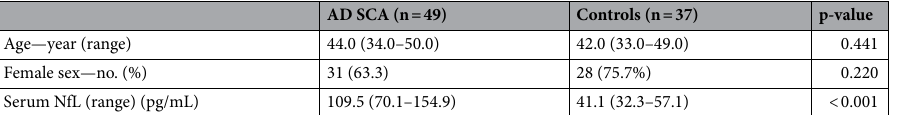
Table 2. Patient characteristics and serum neurofilament light chain of autosomal-dominant spinocerebellar ataxia patients and controls. Data are reported as the number (percentage), or as the median (interquartile range, IQR). AD autosomal dominant, SCA spinocerebellar ataxia, NfL chain neurofilament light